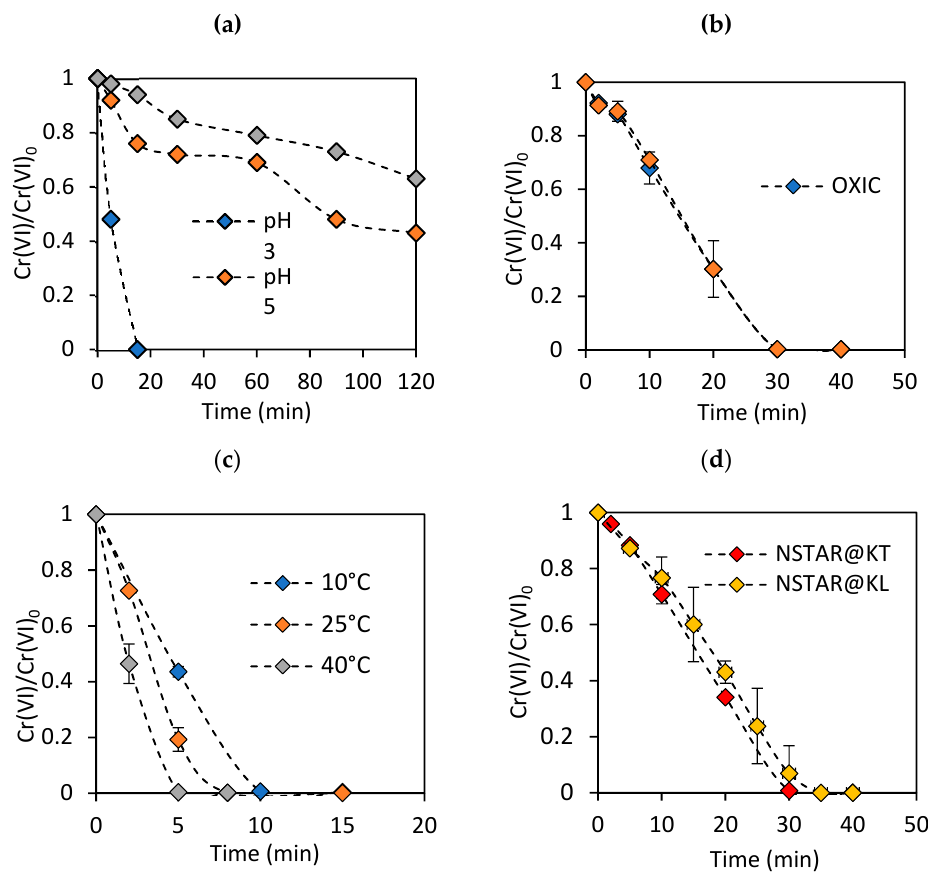
Figure 3. Effect of ( a ) initial pH (N25@KT), ( b ) dissolved oxygen (NSTAR@KT), ( c ) temperature (N25@KT), and ( d ) alginate viscosity for the Cr(VI) removal by nZVI@AL. [ Cr ( VI )]